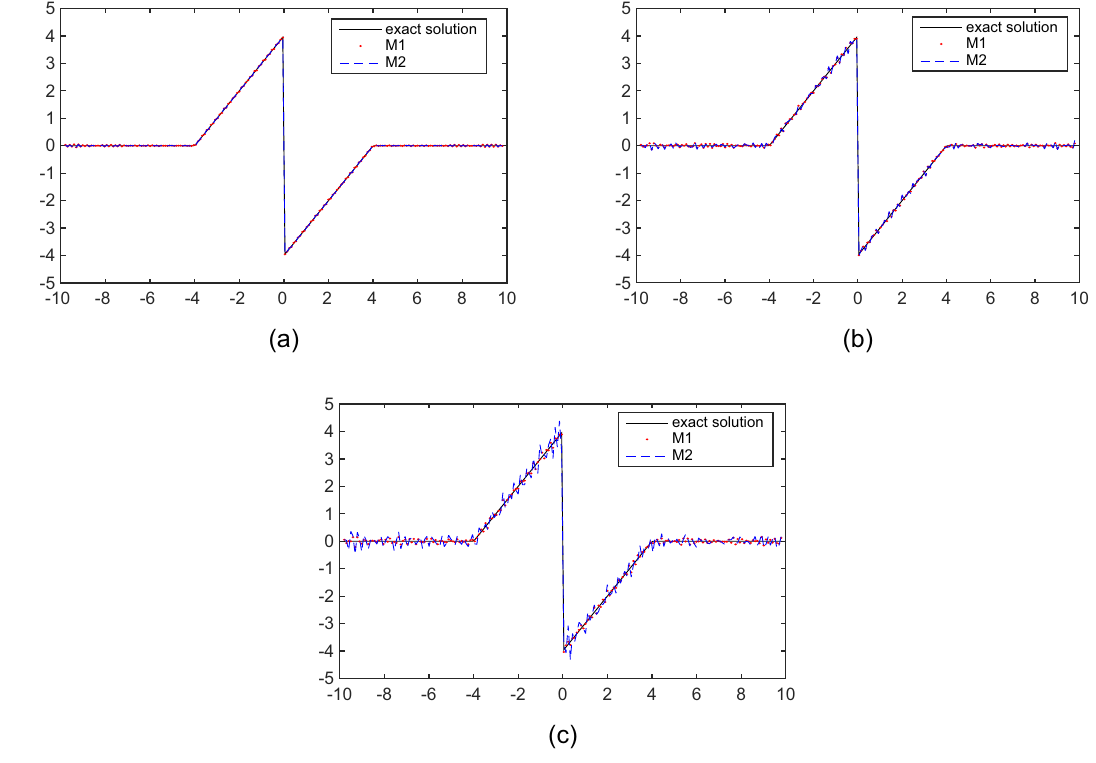
Figure 4: Comparison of exact functions and their approximation ( Example 2 ) . ( a )